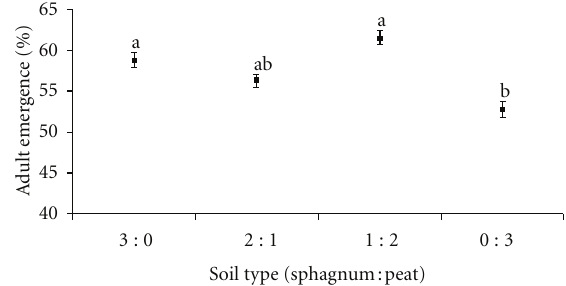
Figure 5: Mean percentage ( ± S.E.) of adults emerging from aestivation when stored in four di ff erent ratios of sphagnum :peat during pupation and aestivation. Means with di ff erent letters are statistically di ff erent ( F (3, 284) = 4 . 10, P = 0 .